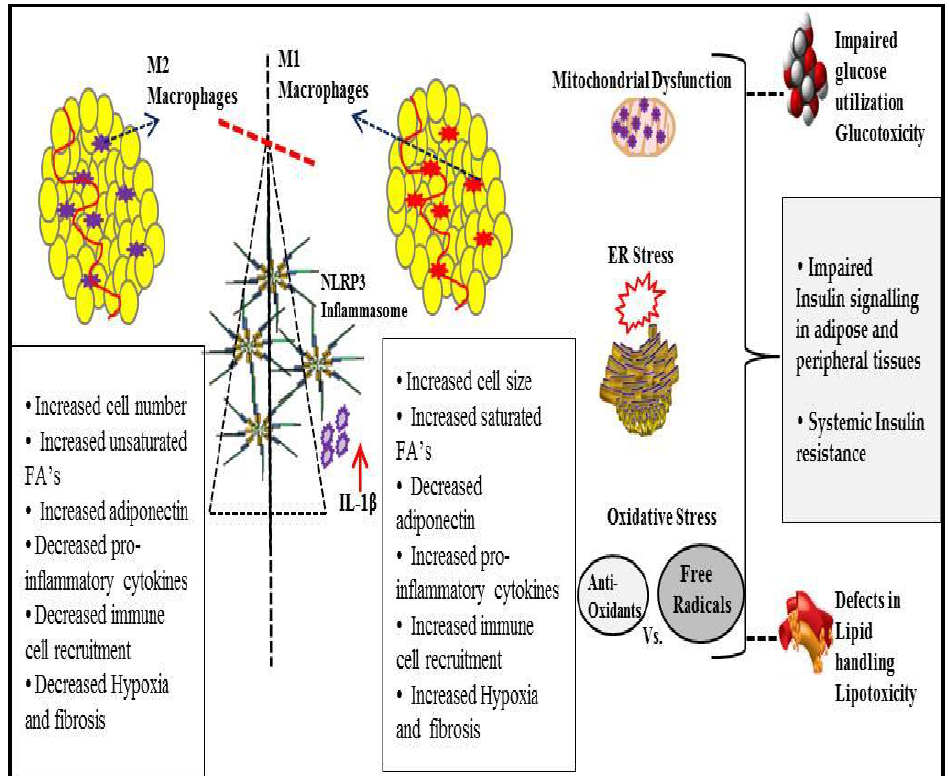
Figure 3. Overview of obesity-associated metabolic inflammation and insulin resistance. NLRP3 inflammasome activation as a consequence of obesity-mediated immunological and metabolic dysregulation, including changes in adipose tissue-resident immune cells, impaired adipogenesis, decreased anti-inflammatory adipokines, hypoxia, fibrosis, etc., and helped by oxidative and ER stress, leads to a glucotoxicity, lipotoxicity, and systemic insulin resistance.